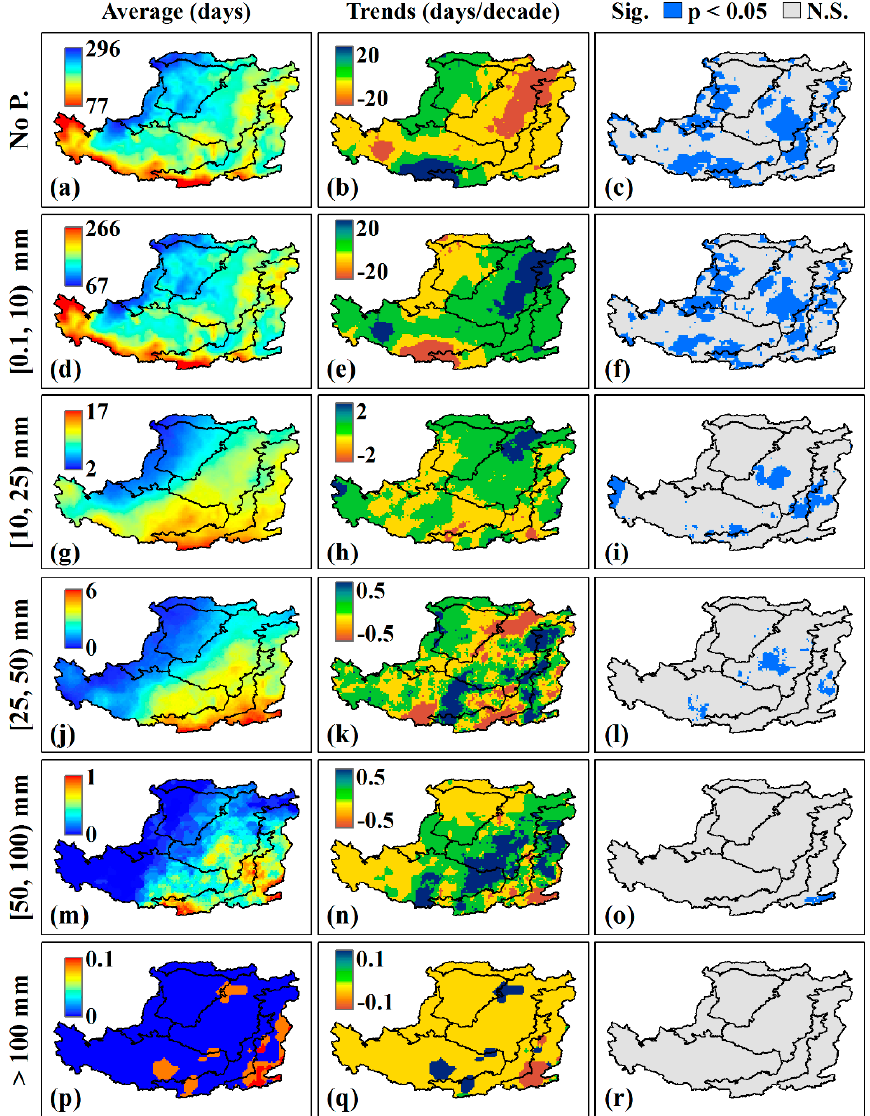
Figure 4. Changes of different precipitation (P.) intensities during the period 1982–2015. ( a – c ) No P. is no precipitation (or, to be more precise, daily precipitation lower than 0.1 mm); ( d – f ) daily precipitation ranging [0.1, 10) mm represents light precipitation; ( g – i ) daily precipitation ranging [10, 25) mm represents moderate precipitation; ( j – l ) daily precipitation ranging [25, 50) mm represents heavy precipitation; ( m – o ) daily precipitation ranging [50, 100) mm represents very heavy precipitation; and ( p – r ) daily precipitation greater than 100 mm represent severe precipitation, respectively. Sig. is the significance level, and N.S. is no significance at the 0.05 statistical level.